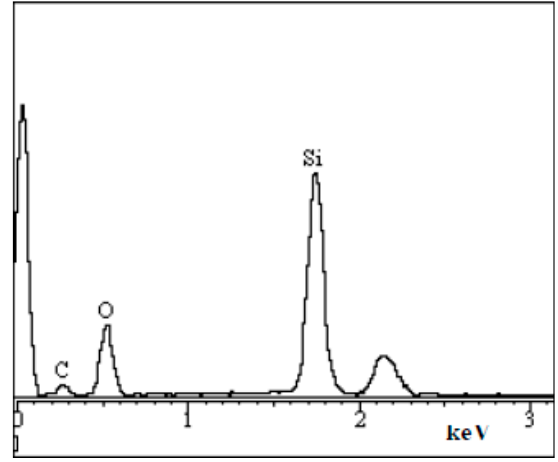
Figure 6. EDS spectrum of the resulting biochar (BRH-900-30).